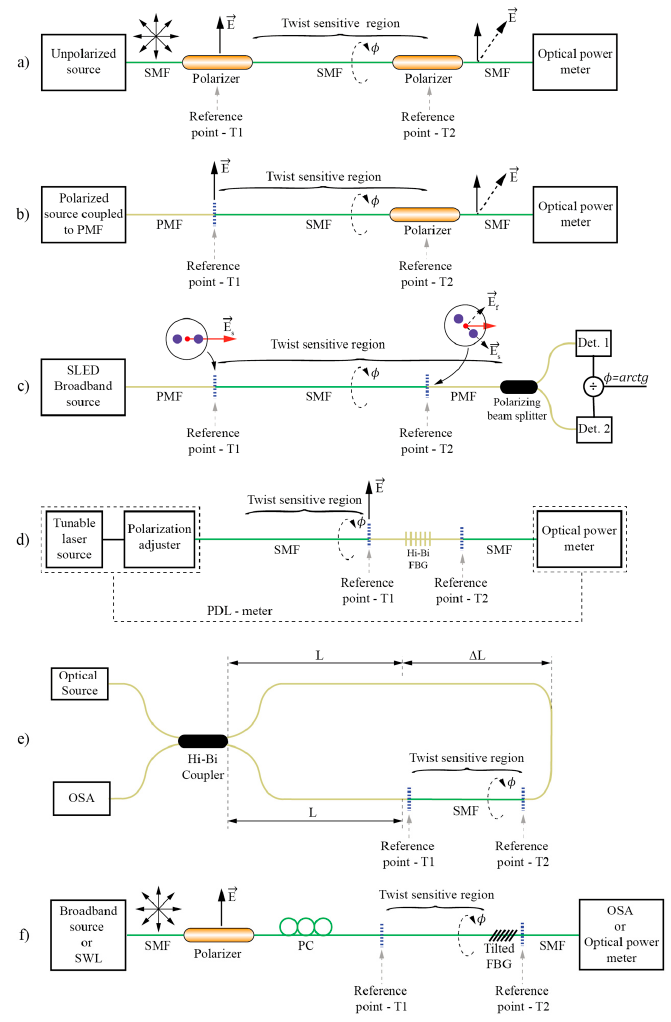
Figure 16. Typical E-field vector displacement rotation sensors’ arrangements.